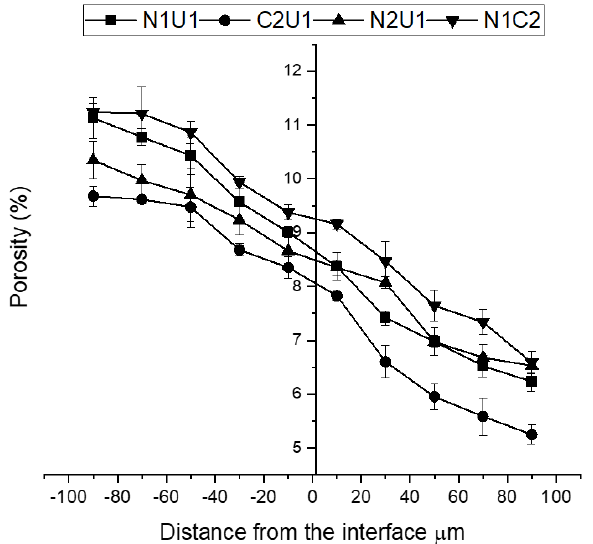
Figure 7. Pore segmentation of the selected area presented in Figure 2.